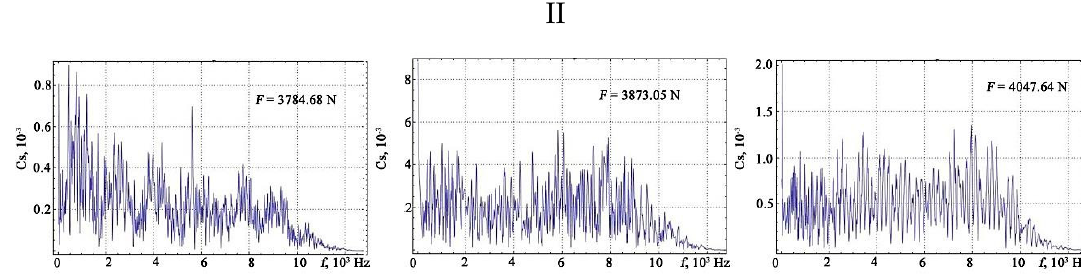
Figure 11. The results of the discrete Fourier transform of the vibration signals under different loads: II—area of the plastic flow of the material.